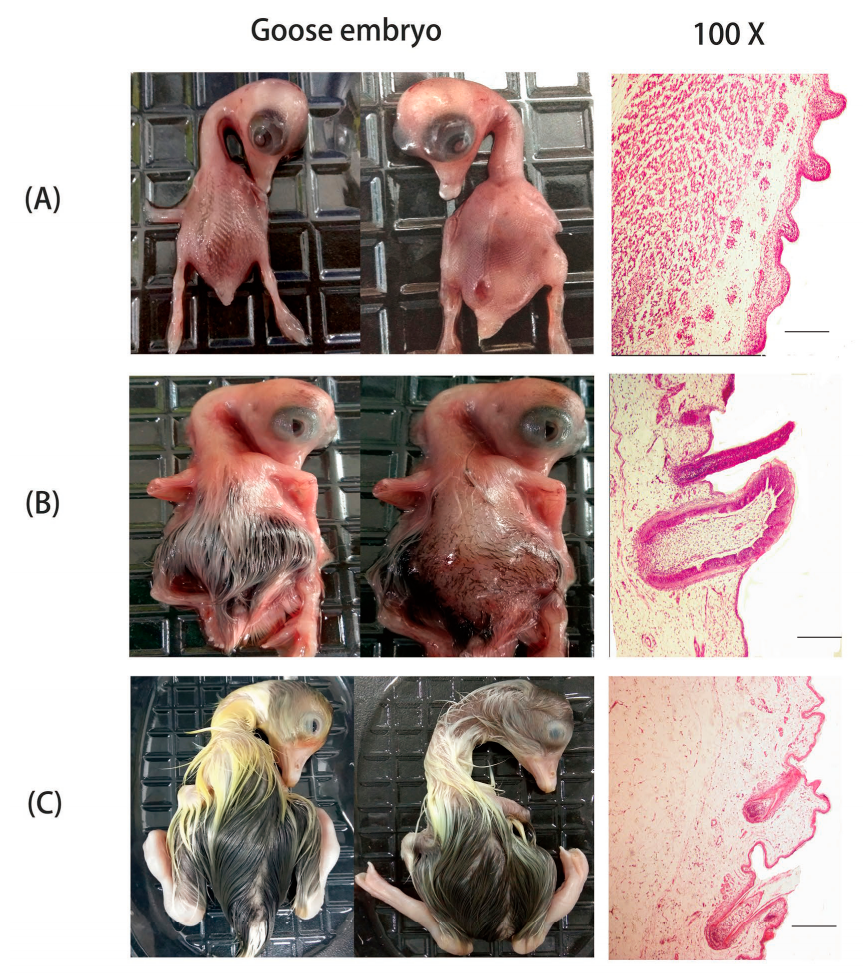
Figure 1. Three different stages in goose embryo skin development based on morphogenesis. Three different stages in goose embryo skin development were analyzed: ( A ) At embryonic day 13 (E13), primordial period of primary feather follicles. ( B ) At embryonic day 18 (E18), primordial period of secondary feather follicles. ( C ) At embryonic day 28 (E28), greater developmental period of secondary feather follicles. Histological sections of the three stages of goose skin during embryonic development (the first column and the second column: photograph; the third column: magnified 100×).